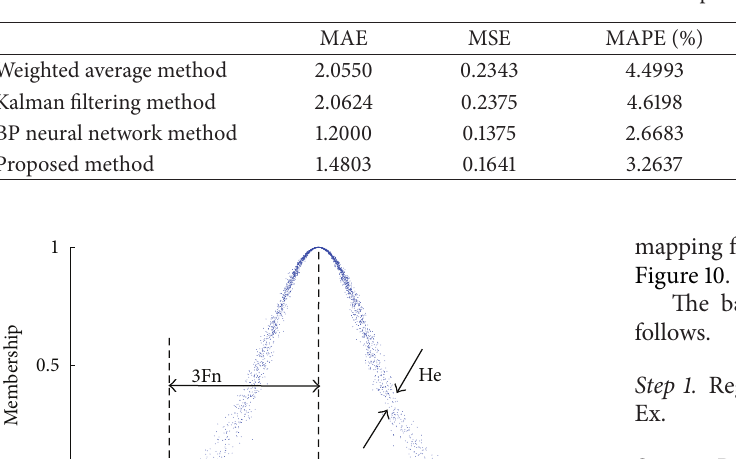
Table 4: Evaluation results of different speed fusion method.